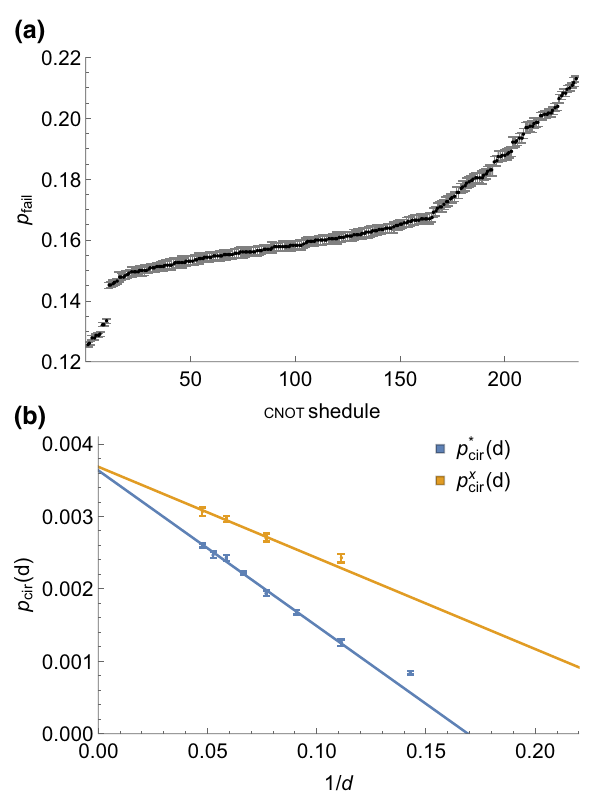
FIG. 14. (a) Logical failure probability over n cyc = 7 cycles for distance d = 7 and depolarizing circuit noise of strength p = 0.0035 for each of the 234 CNOT schedules, sorted by their failure rate. (b) The long-time pseudothresholds p ∗ ( d ) for the best-performing CNOT schedule and crossings p × cir { 4, 1, 2, 3, 6, 5; 3, 2, 5, 6, 7, 4 } under circuit noise; see Appendix B for further details. From a linear extrapolation of the data for d ≥ 11 we obtain intercepts of 0.366(6)% for p ∗ ( d ) . 0.37(1)% for p × cir